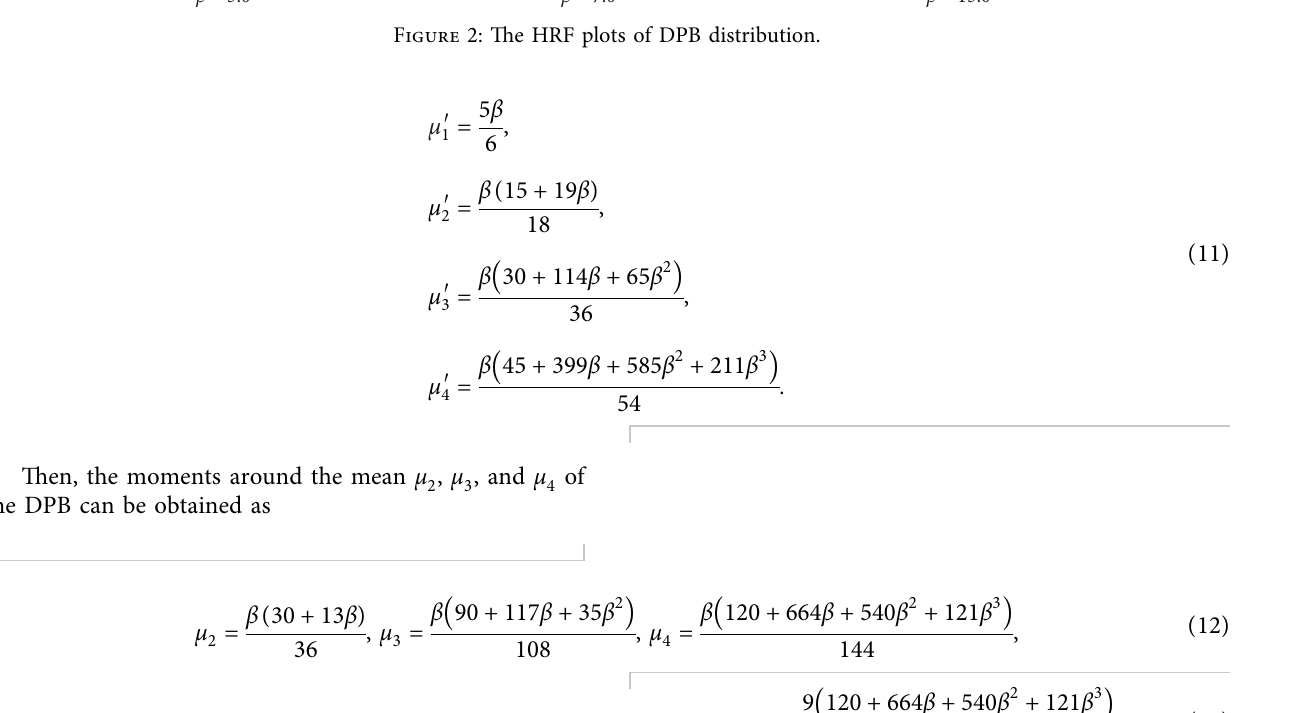
Figure 2: Te HRF plots of DPB